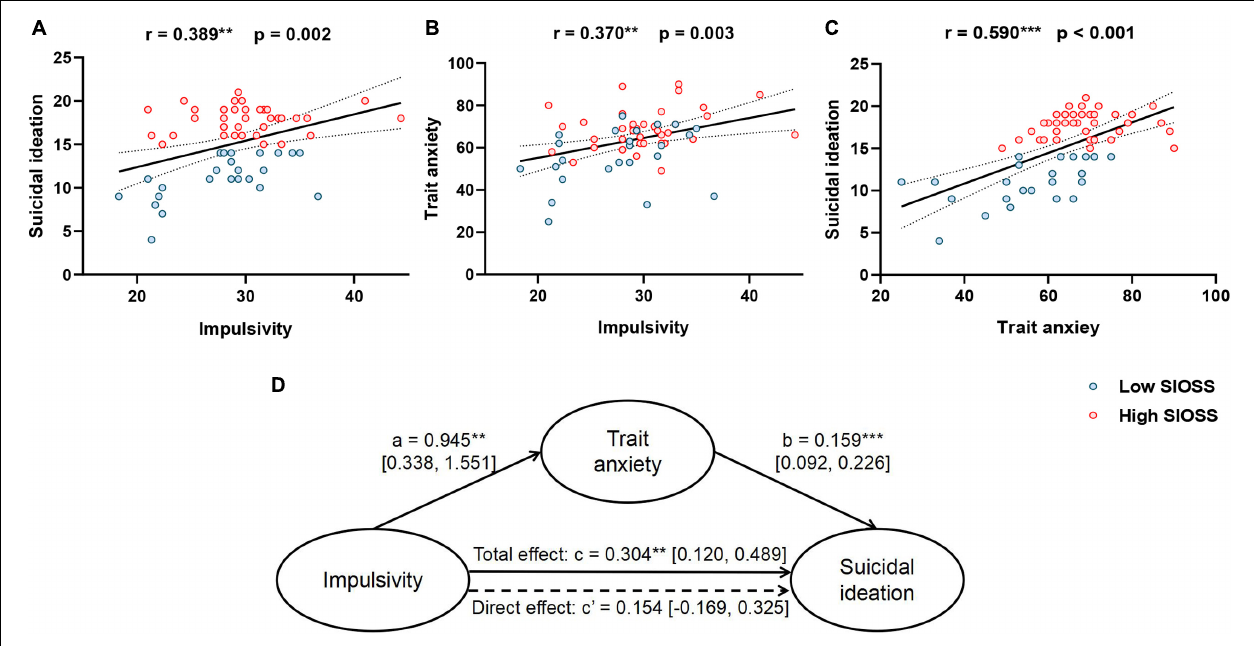
FIGURE 4 | Correlations and mediation model. (A) Correlation between impulsivity and suicidal ideation; (B) Correlation between impulsivity and trait anxiety; (C) Correlation between trait anxiety and suicidal ideation; (D) Mediation model. ** p < 0.01, *** p <